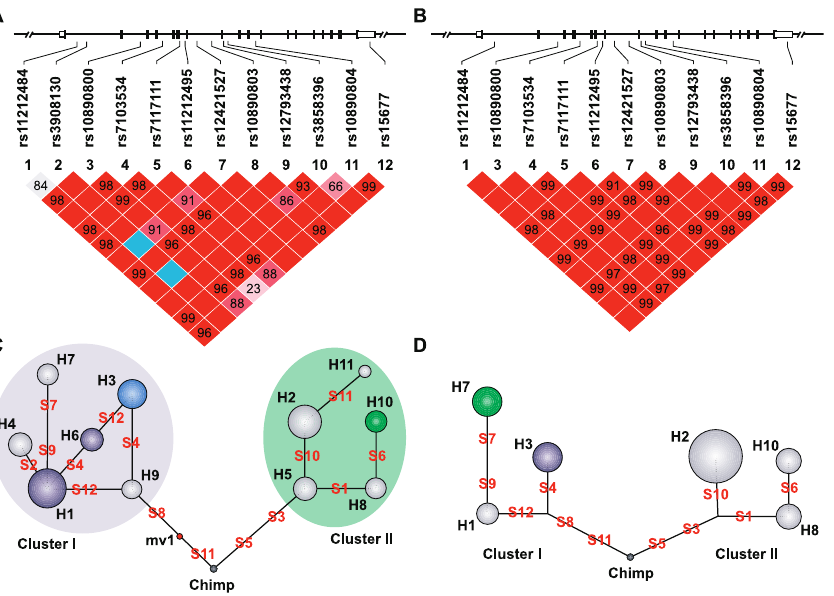
Figure 2. LD of CUL5 SNPs in AA and EA LD of CUL5 SNPs is shown in AA (A) and EA (B). Pairwise D 9 plots were generated using Haploview with its standard color scheme. Dark-red squares indicate high D 9 values, light-blue squares indicate high D 9 values with low LOD scores, and light-red and white squares indicate low D 9 values. D 9 values were indicated for those not equal to 1.0. A single LD block was defined for both AA and EA under the default confidence interval criteria. A reduced-medium network for the genealogical relationship of CUL5 haplotypes is shown in AA (C) and EA (D). The network was inferred in terms of mutational distance, on the basis of 12 CUL5 SNPs and one chimpanzee (Chimp) sequence. Median vector (mv1), the consensus sequences inferred by parsimony criteria, represents possible unsampled sequences or extinct ancestral sequences. Haplotypes (H1–H11) are represented by circles, whose area reflects the number of alleles observed in each population. The solid branches between haplotypes represent mutational events or SNPs (S1–S12). The circles in green show haplotypes with detrimental effect and those in blue show protective effect on AIDS progression in the Cox model analysis; the protective effect of H3 in light blue was of less certainty (see Results). The haplotypes were separated into two clusters, cluster I and II, carrying ctSNP5 A or G, respectively. Cluster I and II in AA are shaded in blue and green, respectively. SNP2 is omitted in (B) and (D) as it was absent in